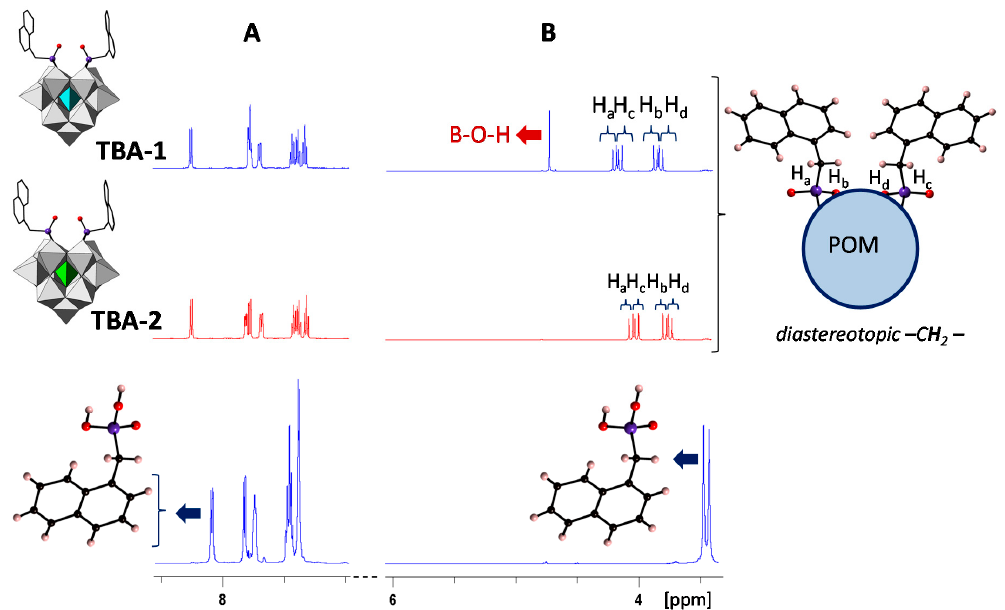
Figure 10. Expanded regions of the naphthyl ( A ) and methylenic ( B ) protons in the 1 H-NMR spectra of TBA-1 and TBA-2 recorded in acetone- d 6 compared with those of the commercial 1-naphthylmethylphosphonic acid. The diastereotopic spin system for the methylenic group in the hybrid POMs 1 and 2 is schematically depicted. The signal assigned to the B–O–H proton is highlighted in red.